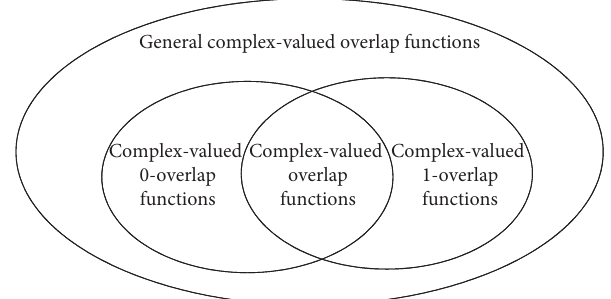
Figure 1: Relations between complex-valued overlap functions, complex-valued 0-overlap functions, complex-valued 1-overlap functions, and general complex-valued overlap